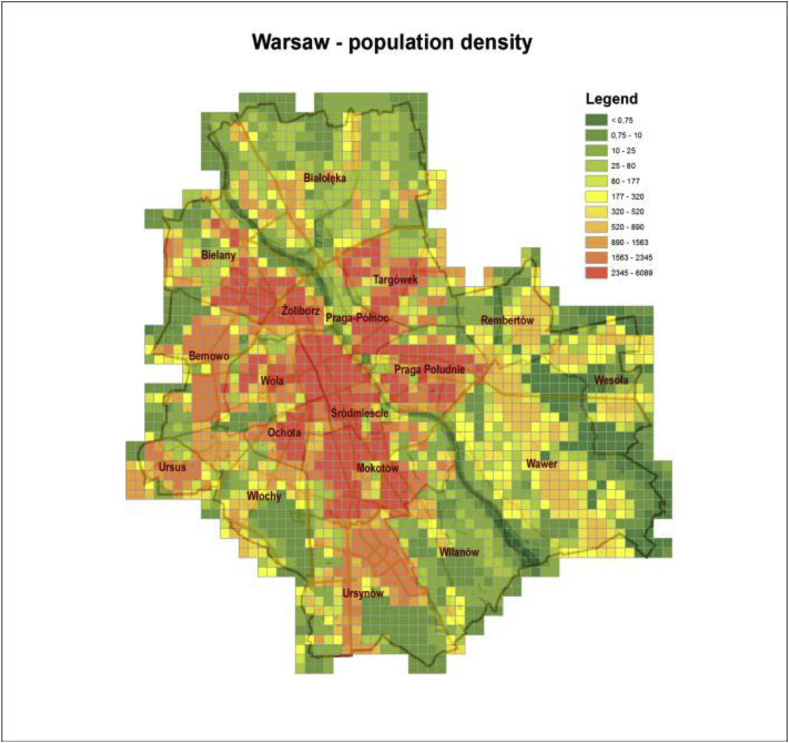
Population density map for Warsaw [persons per 0.25 km2] (Holnicki et al., 2017b).